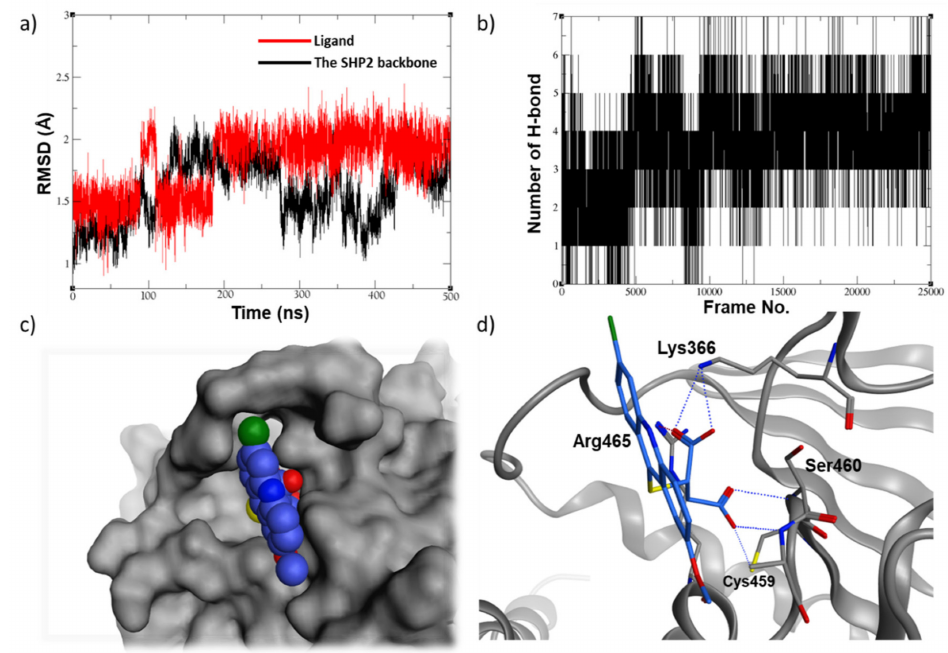
Figure 5. ( a ) The RMSD plot of the 500 ns MD simulations of compound 13030 along with ( b ) the hydrogen bonding plot, ( c ) the top-cluster conformation filling (blue spheres) in the SHP2 active site (gray surface), and ( d ) the ligand 3D binding mode showing the key interactions made with the surrounding